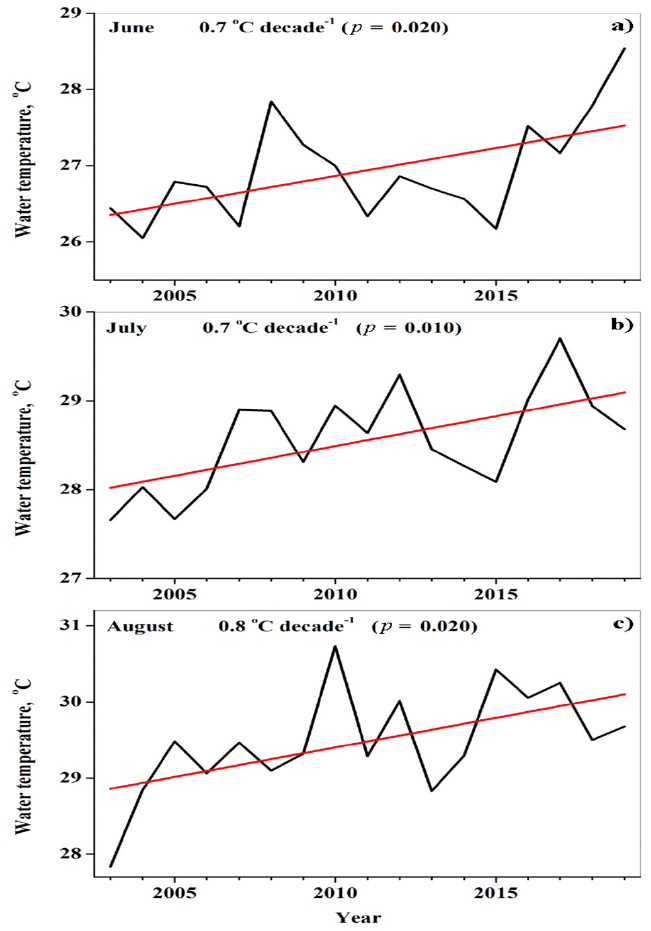
Figure 8. Year-to-year variations of Kinneret near-surface water temperature in ( a ) June, ( b ) July, and ( c ) August, based on in-situ measurements, during the period under study (2003–2019). The straight red lines designate linear fits.